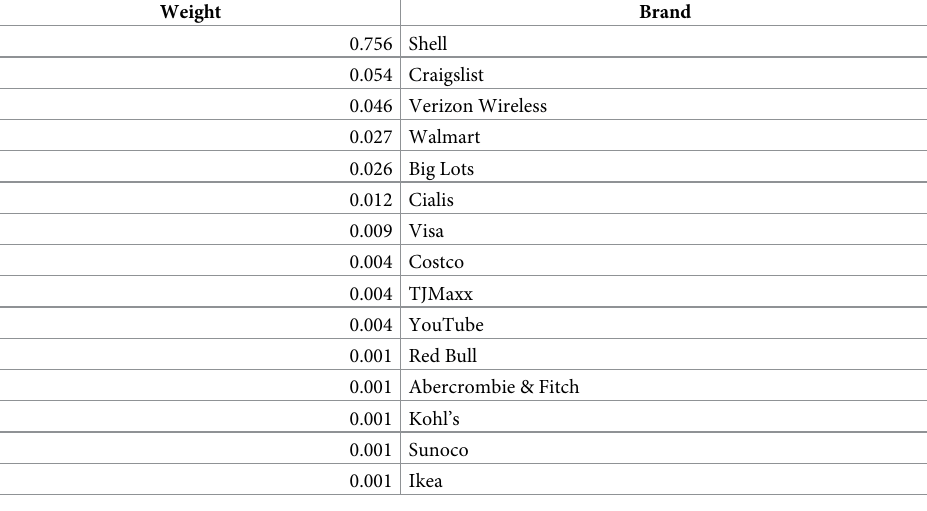
Table 1. Components of synthetic